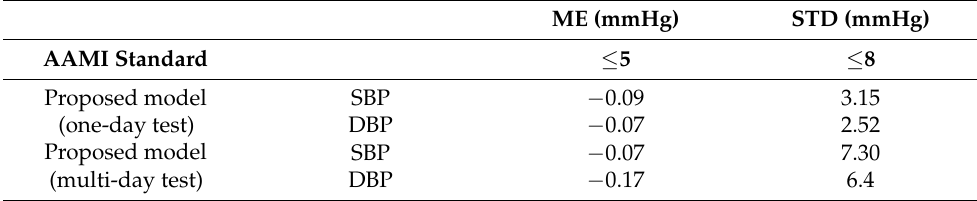
Table 7. Performance evaluation using Advancement of Medical Instrumentation (AAMI)